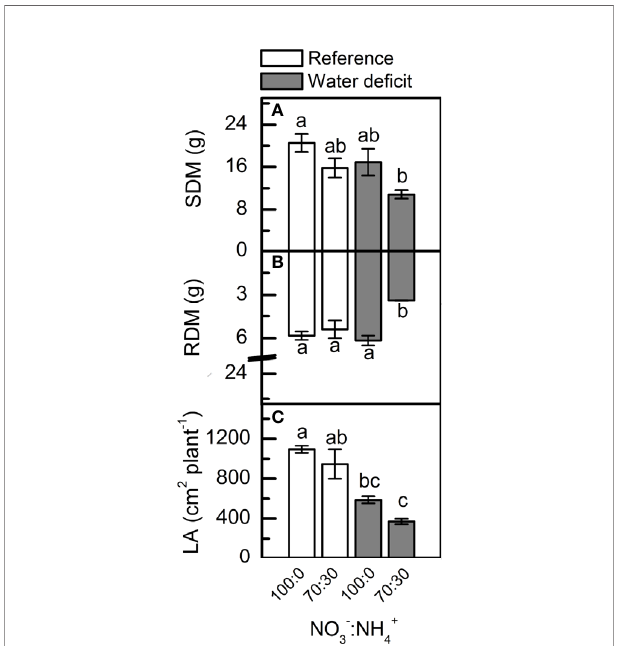
FIGURE 7 | Shoot [SDM, in (A) ] and root [RDM, in (B) ] dry mass and leaf area [LA, in (C) ] of sugarcane plants maintained well-hydrated (reference, white bars) or subjected to water de fi cit (gray bars) and supplied with varying NO 3 − :NH 4+ ratios: 100:0 and 70:30. Bars represent the mean value of four biological replicates ± se. Different letters indicate statistical difference among treatments (BF 10 > 3 for SDM and LA; BF 10 > 20 for RDM).